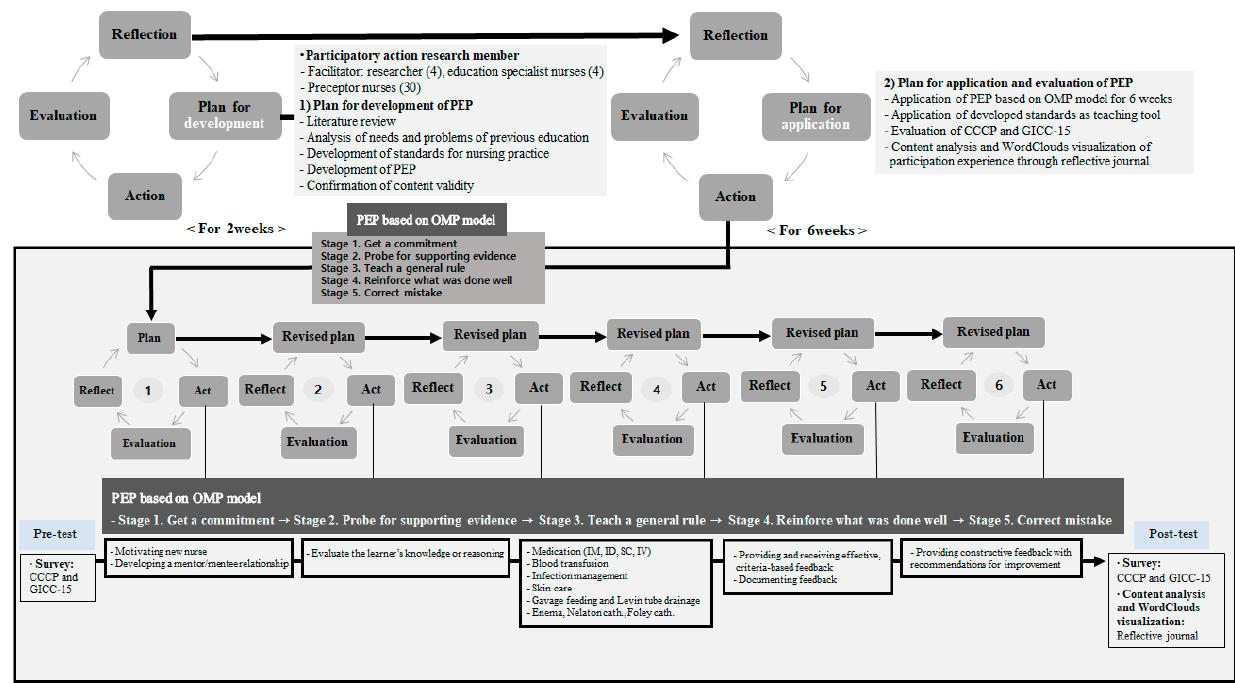
Figure 1. PEP based on the OMP model through PAR.